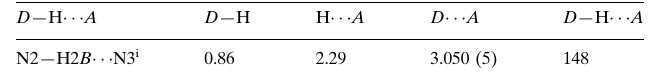
Hydrogen-bond geometry (A˚ , (cid:2)